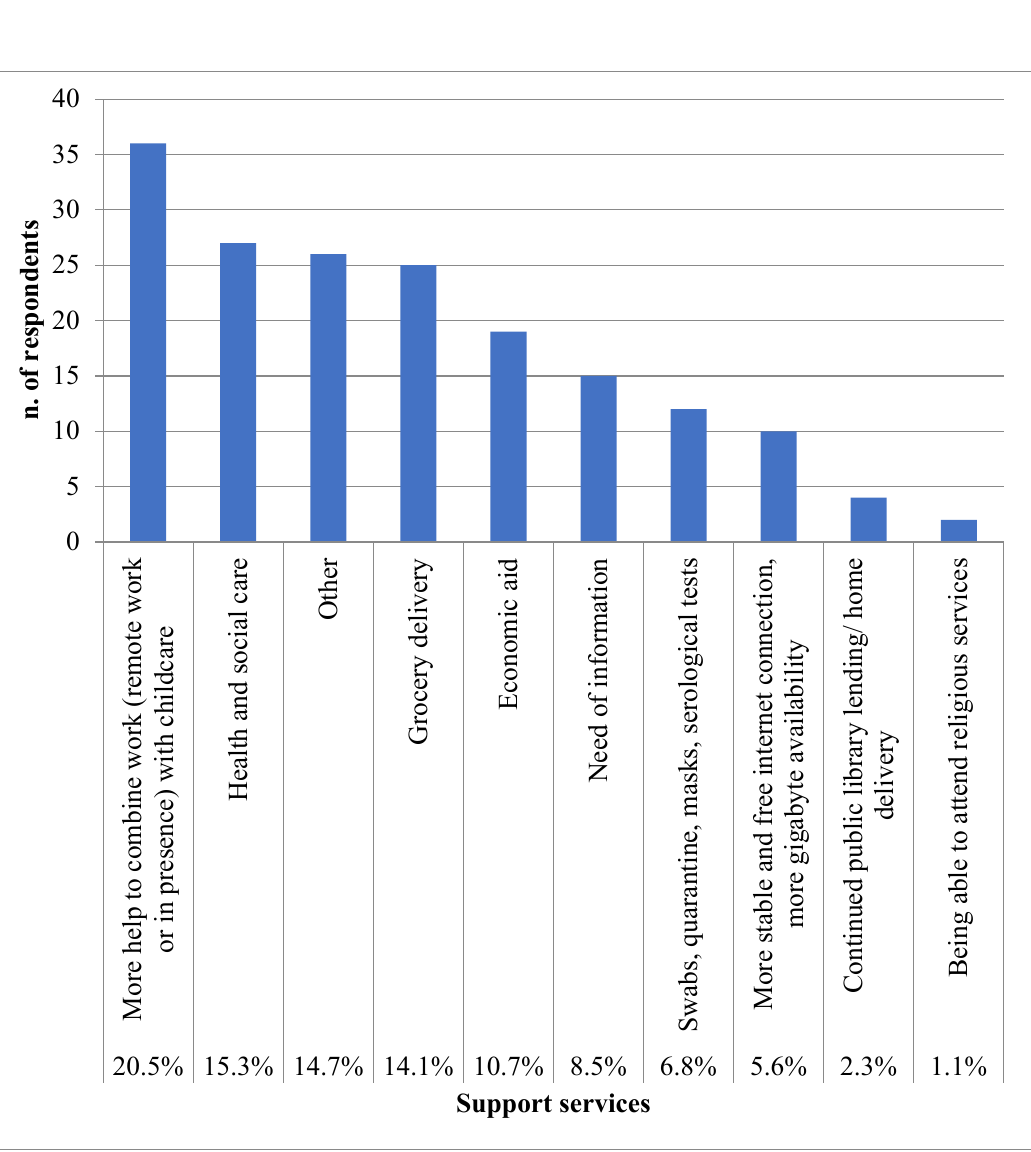
Figure 4. Percentages of participants who would have liked to use support services, described also as types, which were not available during the first lockdown.